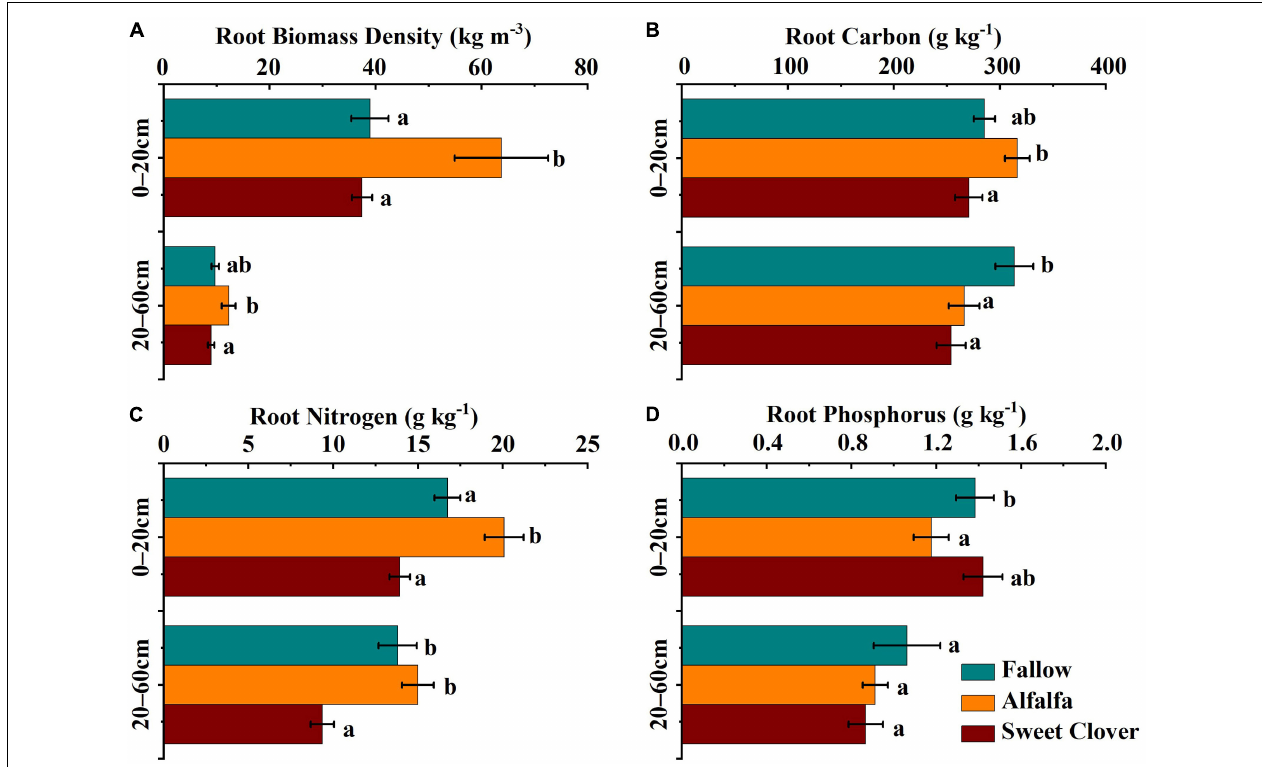
FIGURE 1 | Root biomass density (A) , carbon (B) , nitrogen (C) , and phosphorus (D) distributions at different soil depths under different revegetation treatments in 2019 (17 years after revegetation). Data represents the mean value ± standard error ( n = 9), and the different letters indicate significant differences at the p < 0.05